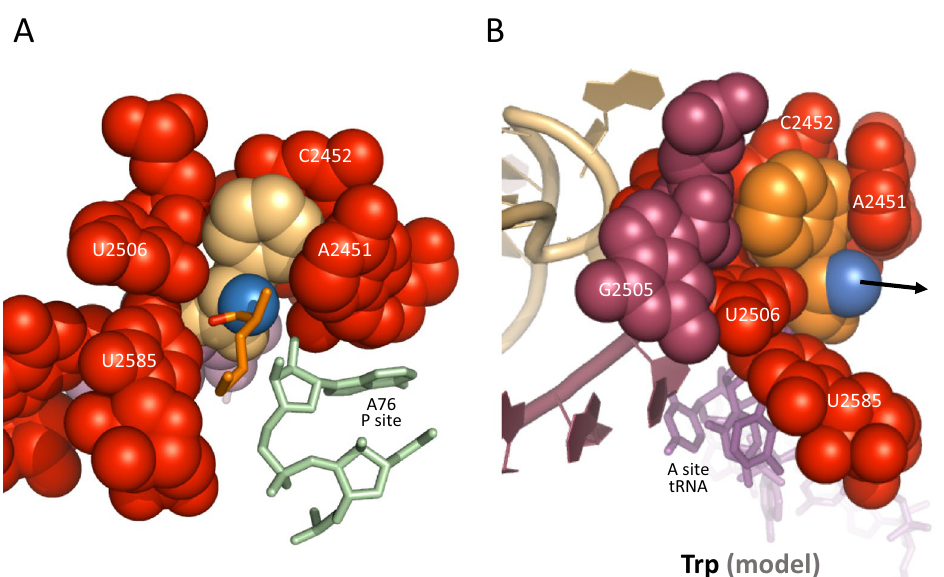
Figure 3. Constraints on translocation with partially decompacted PTC. ( A ) This view reveals that partial decompaction of the PTC may interfere with the translocation of the 3 ʹ end from the A site to the P site (most atoms are shown as van der Waals spheres) (pdb 1vy5) 18 . To compare with Fig. 2B. ( B ) Induced PTC with tryptophanyl-tRNA on the A site of the ribosome. This configuration was obtained with a Phe → Trp mutation in the pdb 4V5D structure 12 as the only modification. It suggests that very large amino acids such as tryptophan are trapped in induced (compacted) PTC, which may prevent CCA 3’ end translocation (arrow) if peptide bond formation would not promote